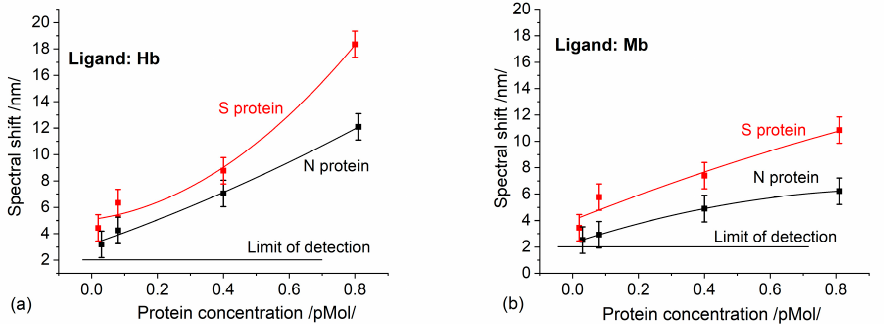
Figure 3. А spectral shift as a result of S/N proteins binding to: ( a ) Hb; ( b ) Mb. Apparently, binding to S/N proteins occurs in the heme group, inhibiting its functionality. The thiol group, responsible for NO metabolism, maintains its